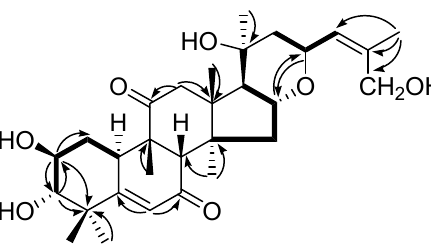
Figure 2. Key 1 H- 1 H COSY (bold items) and HMBC (arrows) correlations of compound 1 .